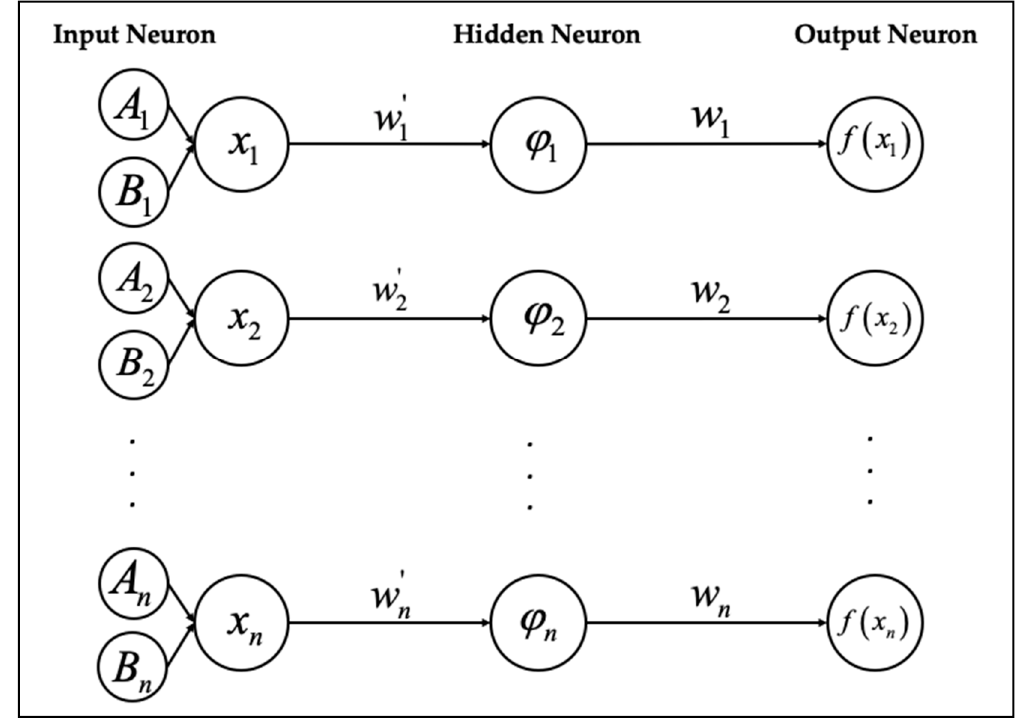
Figure 2. Structure of SAT P 2 in RBFNN.